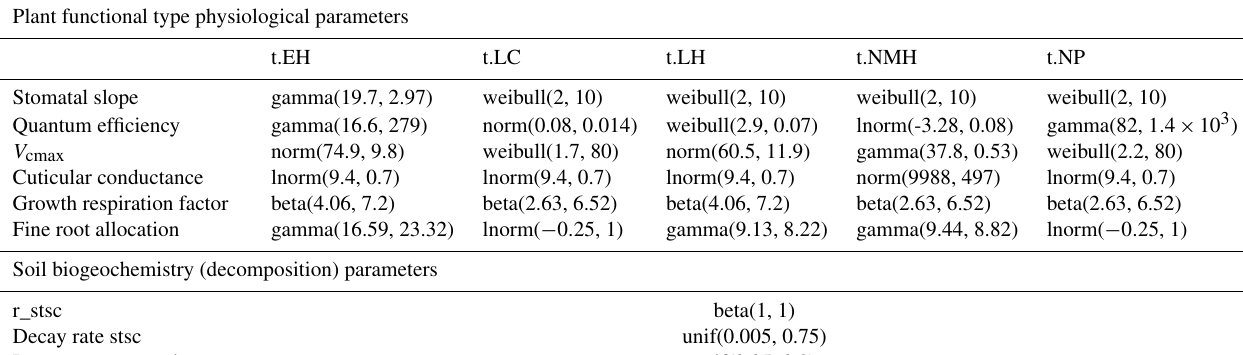
Table A5. The PDA prior (meta-analysis posterior) approximated parametric distributions of the targeted ED2 parameters. Plant functional type physiological parameters